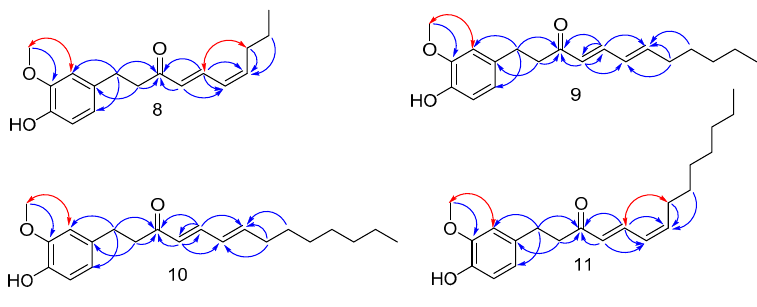
Figure 3. Key HMBC (blue) and NOESY (red) correlations of compounds 8 – 11 . Table 2. 1 H- (500 MHz) and 13 C-NMR (125 MHz) data for compounds 5 and 8 – 11 in CDCl 3 ( δ in ppm, J in Hz).